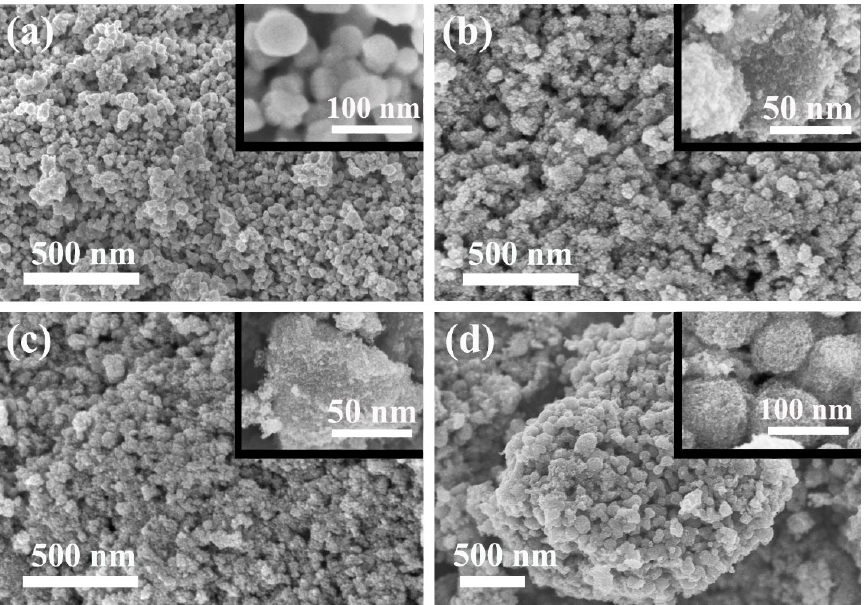
Figure 2. SEM image of the ( a ) CWO, ( b ) CWO@0.2TiO 2 , ( c ) CWO@0.4TiO 2 , ( d ) CWO@0.6TiO 2 (inset shows a magnification of one segment).